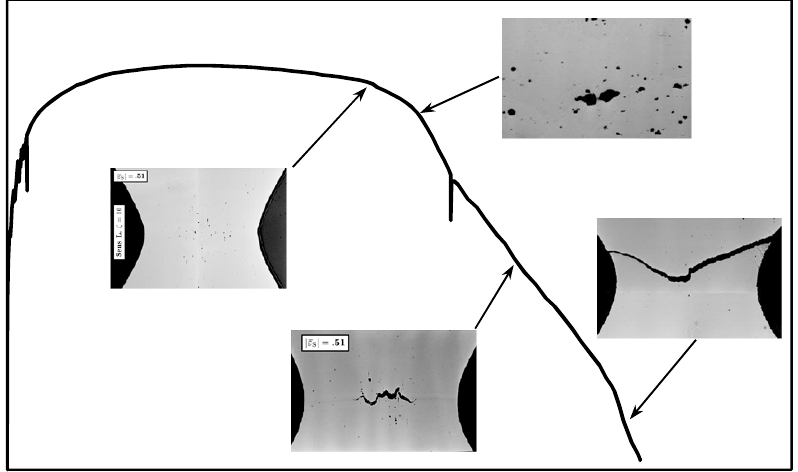
Figure 1. Typical example of micro-cracks coalescence in metals leading to the